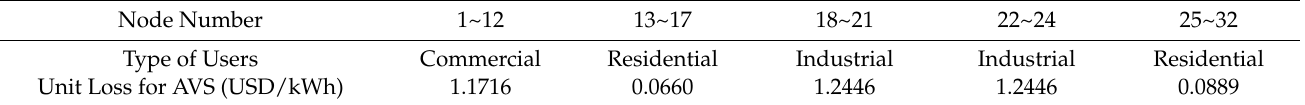
Table 3. Parameters of distributed energy sources.